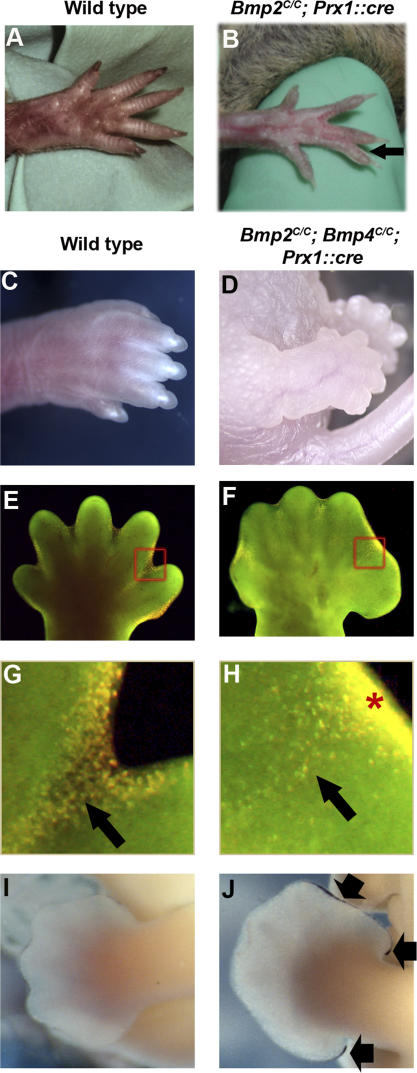
Depletion of BMP Signaling Causes Interdigital Syndactyly(A–D) Forelimb of adult wild-type (A) and Bmp2C/C; Prx1::cre mouse (B) and hindlimbs of newborn wild-type (C) mouse and newborn Bmp2C/C; Bmp4C/C; Prx1::cre (D) mouse. The black arrow in (B) shows soft tissue syndactyly in Bmp2C/C; Prx1::cre mouse.(E and F) Wild-type and Bmp2C/C; Bmp4C/C; Prx1::cre, respectively, showing acridine orange–stained hindlimbs of E15.5 mouse embryos. Acridine orange stain is in yellow.(G and H) Enlarged views of selected regions from (E) and (F), respectively. Black arrow in (G) and (H) show acridine orange–stained apoptotic cells in the interdigital mesenchyme, and asterisk in (H) shows the remnant of the AER.(I and J) Fgf8 mRNA expression in the hindlimbs of E13.5 wild-type (I) and Bmp2C/C; Bmp4C/C; Prx1::cre (J) embryos. The thick black arrows in (J) show Fgf8 mRNA expression.